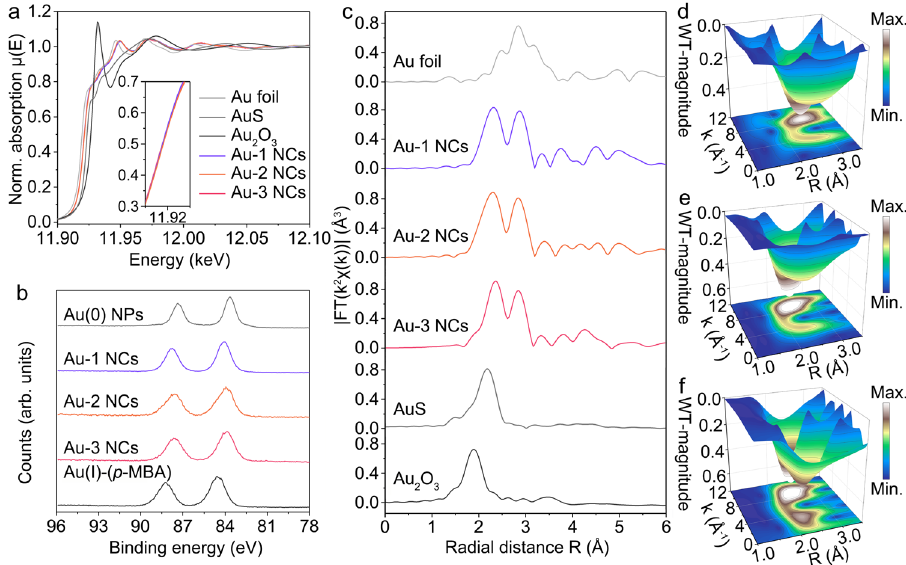
Fig. 2 | Electronic properties and local structures of Au-1, Au-2, and Au-3 NCs. a Au L 3 -edge XANES spectra of Au foil, AuS, Au 2 O 3 , Au-1, Au-2, and Au-3 NCs; the inset shows the magni fi ed XANES spectra in the energy range of 11.919-11.925 KeV. b Au 4 f XPS spectraofAu(0) NPs (gold NPs), Au(I)-( p -MBA) complexes, Au-1, Au-2,